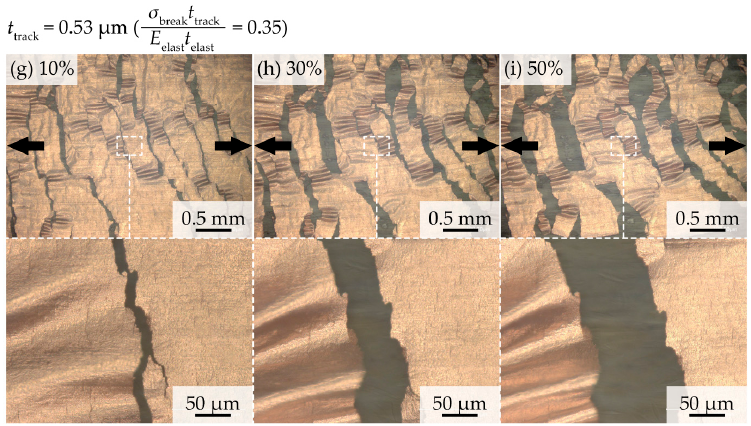
Figure 5. Series of optical images of a cracked copper track in PU with track thicknesses of ( a – c ) 0.04 μ m; ( d – f ) 0.53 μ m; and, ( g – i ) 0.10 μ m.